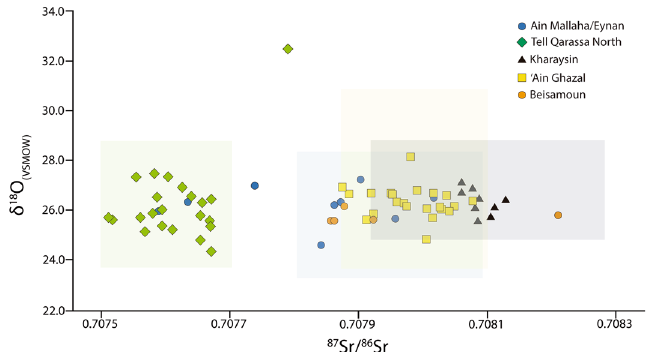
Figure 3. Scatter plot of δ 18 O carb(VMOW) and 87 Sr/ 86 Sr isotope ratios for the 67 individuals from the